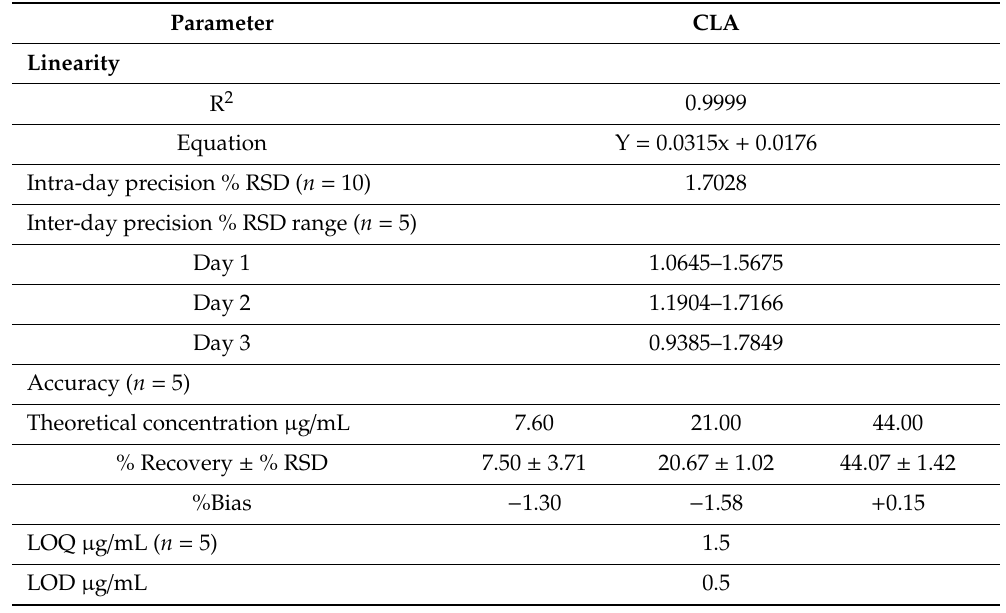
Table 7. Summary of re-validation results for HPLC method for CLA analysis.